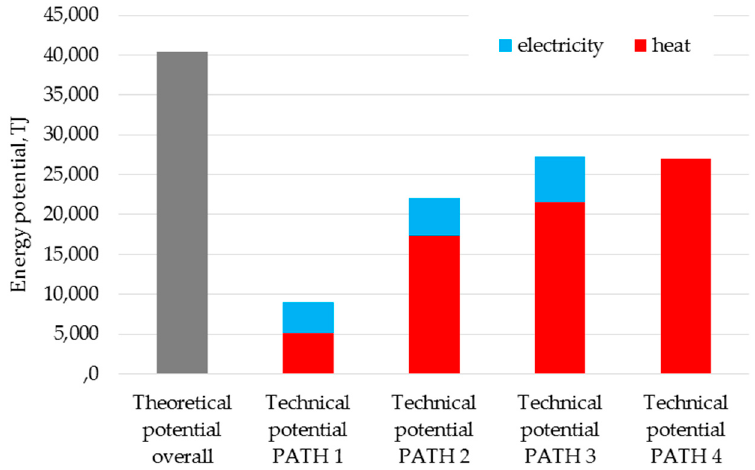
Figure 6. Energy potential of chicken manure determined for Poland according to different technical